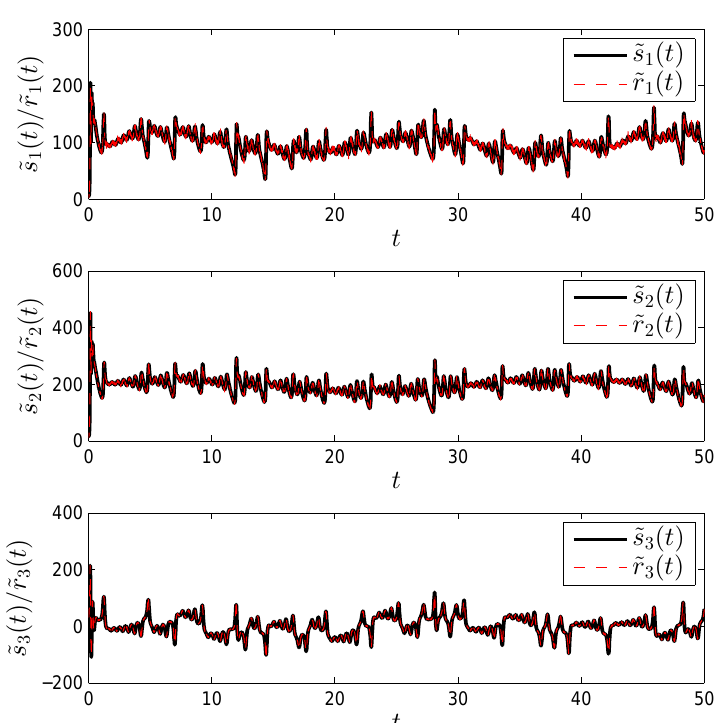
Figure 7. The transmitted signals (cid:101) s i ( t ) as well as the equalized signals (cid:101) r i ( t ) for an SNR of 40 dB.